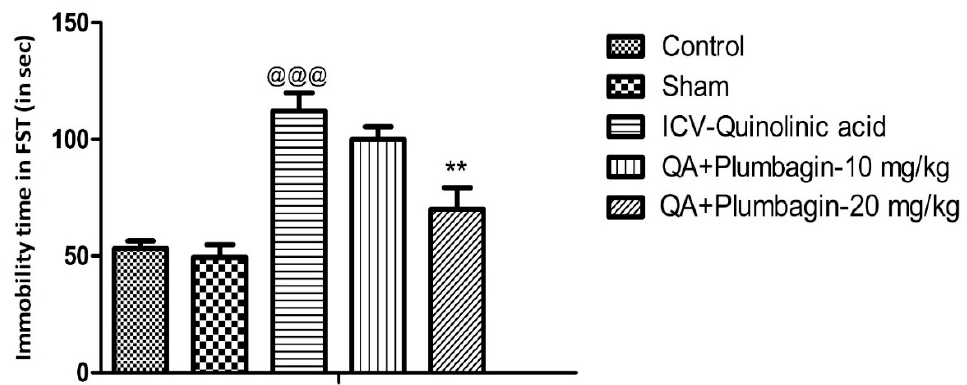
Figure 1. Effect of plumbagin on QA-induced alterations in immobility time during forced swim test. Data represent mean ± SEM ( n = 6). @@@ p < 0.001 as compared control group; ** p < 0.01 as compared to QA-induced group.